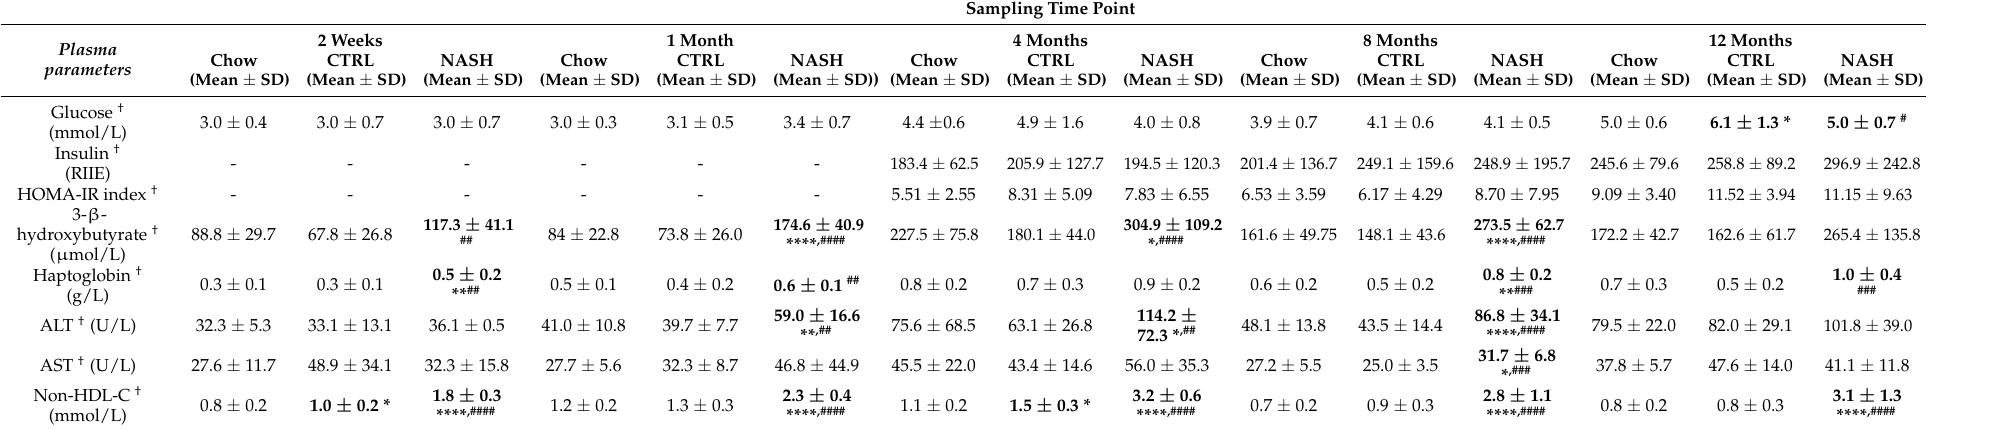
Table 2. Plasma parameters in chow, CTRL, and NASH-fed hamsters during the